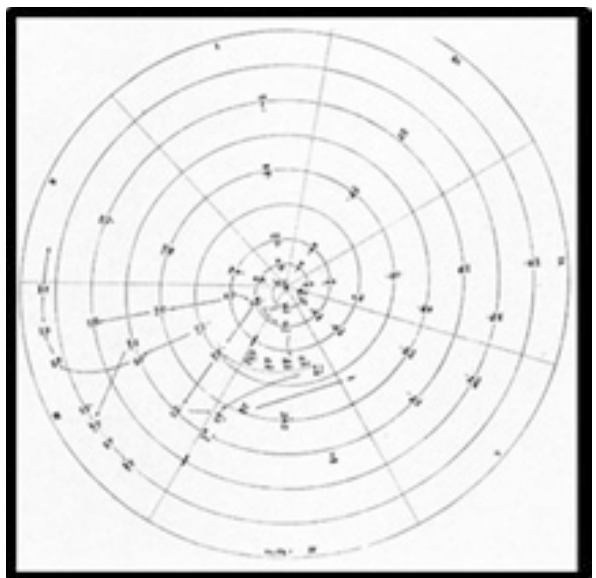
Figure 12. The first circular table.